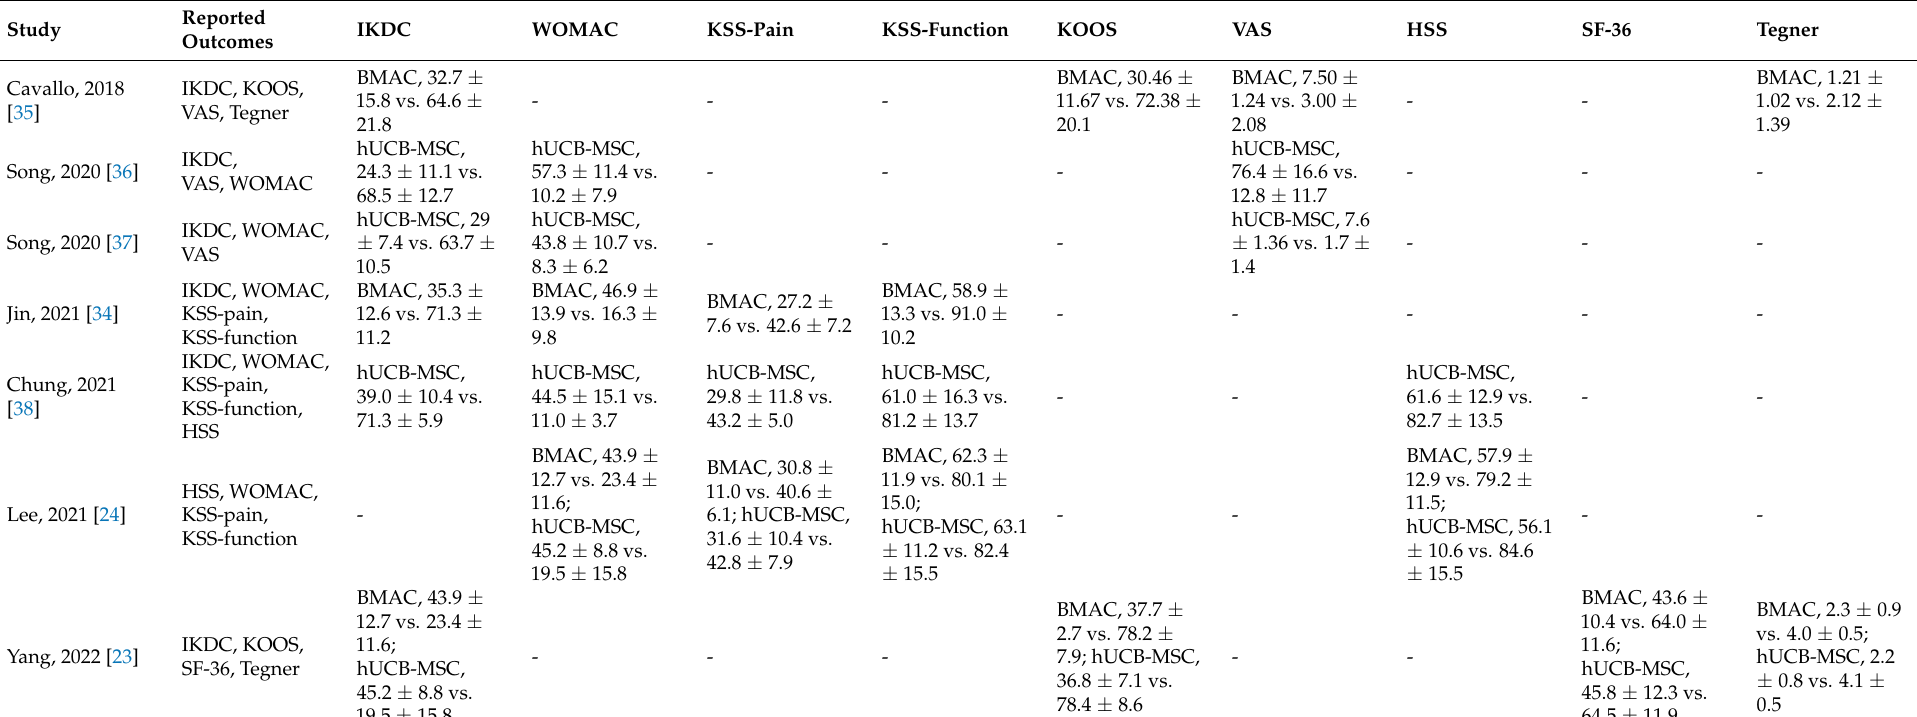
Table 4. Reported clinical outcome measures of the included